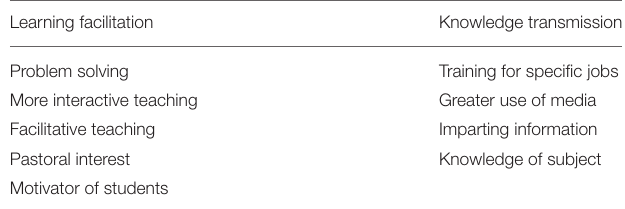
TABLE 4 | Gow and Kember’s (1993) orientations to